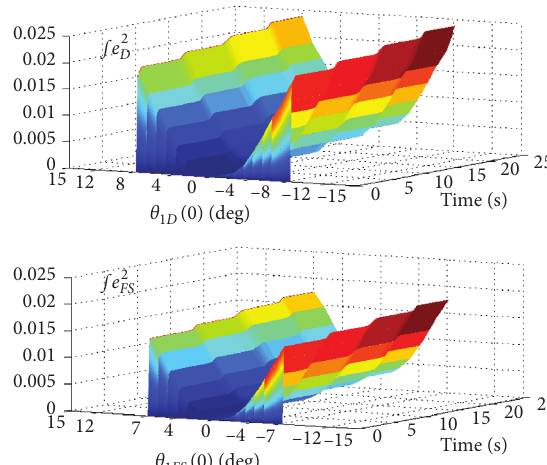
Figure 24: Assessment of the quadratic error index for the first link.